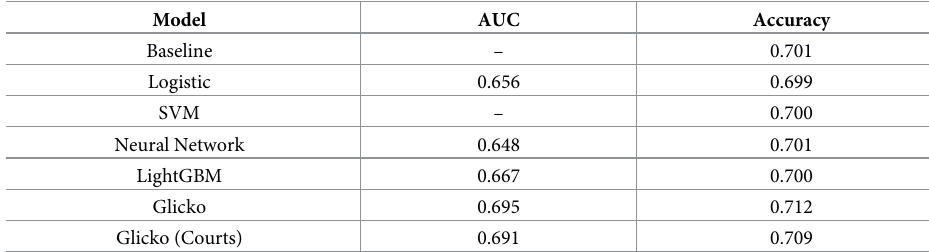
Table 3. Model comparison of WTA single matches (moving